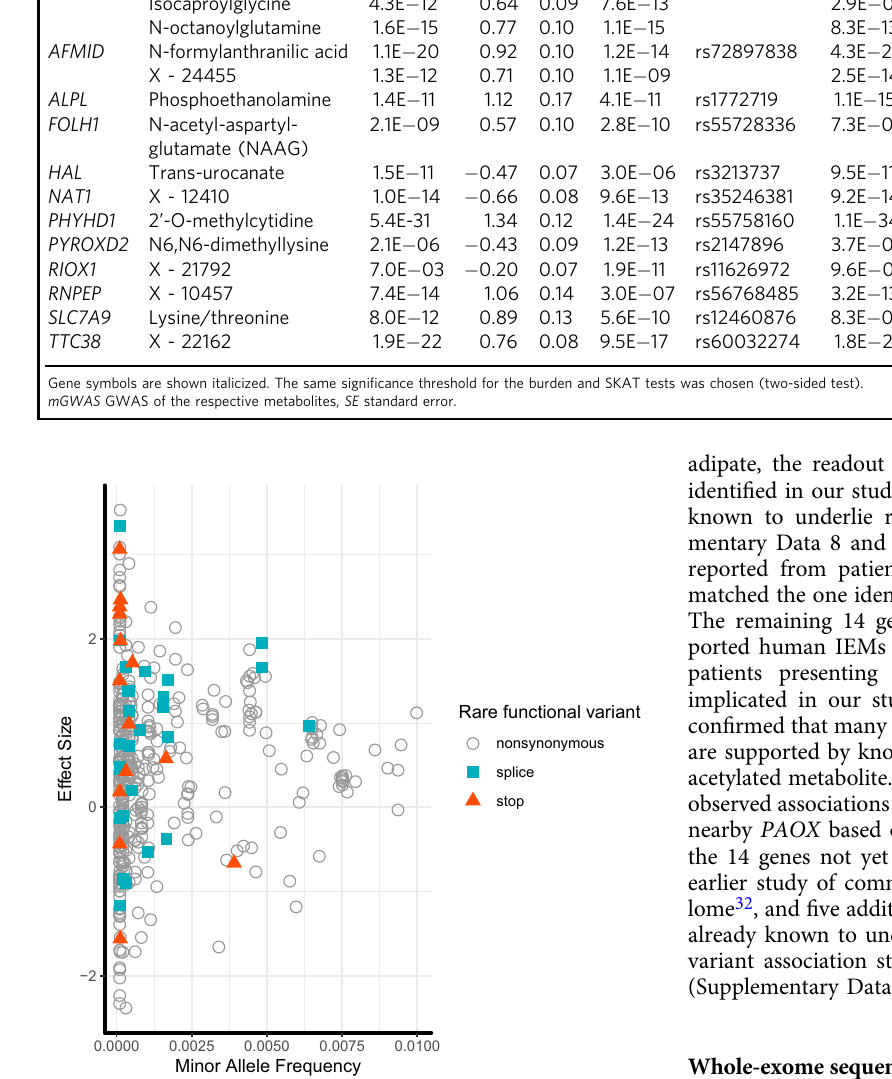
Fig. 2 Effect size on metabolite levels (Y-axis) versus frequency (X-axis) of rare, putative damaging variants included in gene-based tests. The symbols depict the effect of each variant that contributed to an aggregate association signal on the level of each signi fi cantly associated metabolite. Variants associated with more than one metabolite are therefore included for each metabolite because their associated effects can differ. The Y -axis represents the variants ’ effects on inverse normal transformed metabolite levels; one unit represents one standard deviation. Color-coding and marker shape represent the consequence of 218 variants in the 26 metabolite- associated genes: white circle (nonsynonymous), cyan square (splice), orange triangle